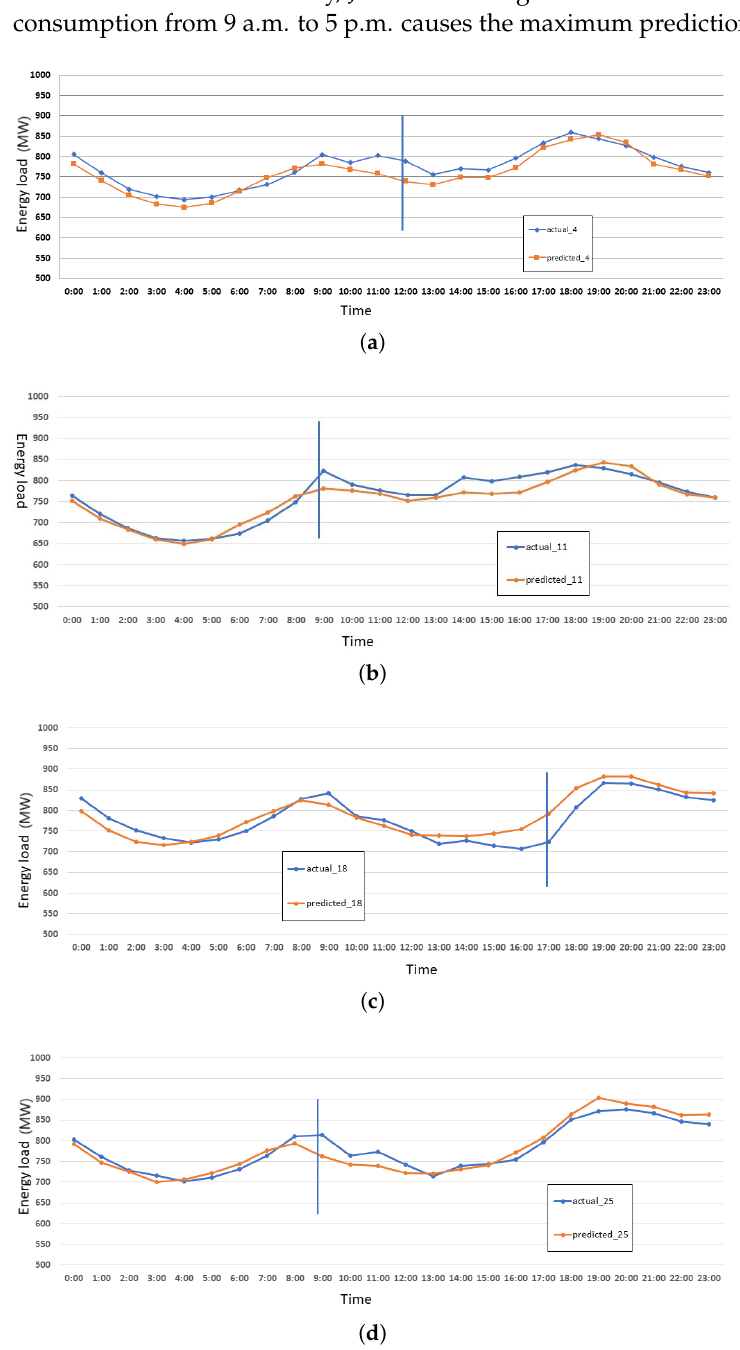
Figure 11. Highest errors recorded in the Fridays in the month of January. ( a ) Friday, 4 January 2019; ( b ) Friday, 11 January 2019; ( c ) Friday, 18 January 2019; ( d ) Friday, 25 January 2019. Other than weekends, we also analyzed the weekdays of the selected month. For exam- ple, Figure 12 represents energy consumption on Wednesdays in Jan 2019, which occurred on the 2nd, 9th, 16th, 23rd, and 30th of that month. the X-axis represents the time of day in hours and the Y-axis shows the energy consumption load. Energy consumption recorded during the daytime is less as compared to the